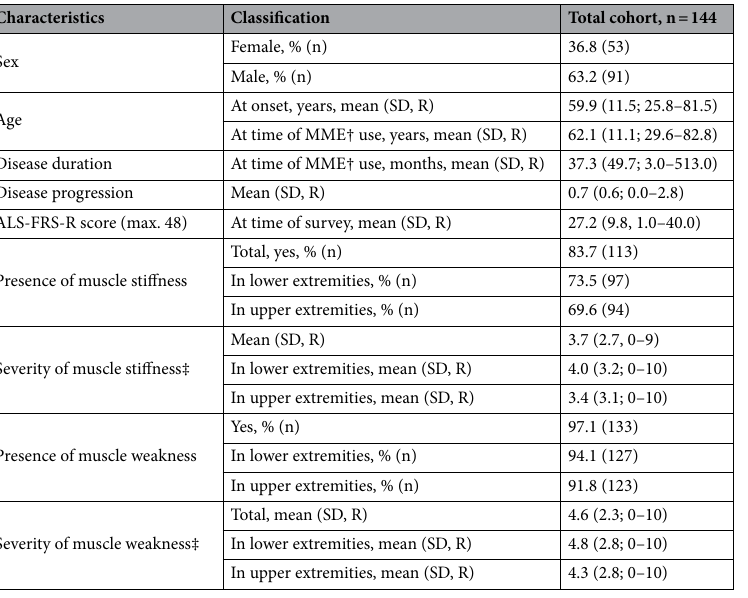
Table 1. Demographic and clinical characteristics of the cohort. n number of participants, SD standard deviation, R range, ALS‑FRS‑R Amyotrophic Lateral Sclerosis Functional Rating Scale, revised, MME Motor- assisted movement exerciser. † Disease duration at the time of the initial MME use. ‡ Severity of muscle stiffness/weakness was assessed via a numeric rating scale (NRS) with 0 meaning no stiffness or weakness and 10 designating the most stiffness or